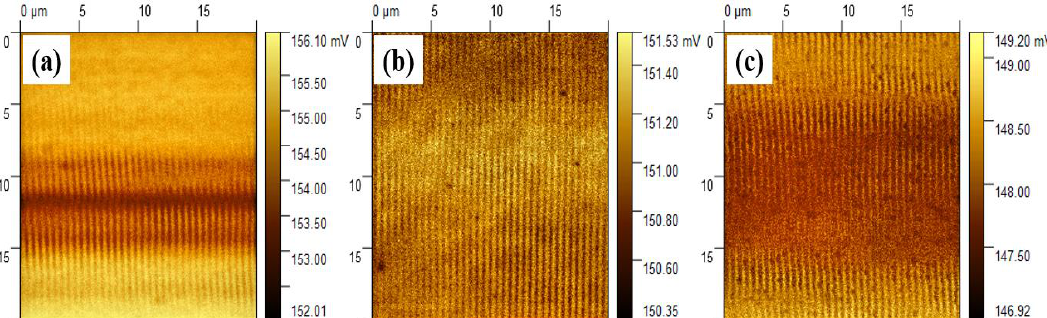
Figure 4. ( a – c ) MFM phase images showing the stripe domains in the thickest YIG films on (100), (110), and (111) YAG